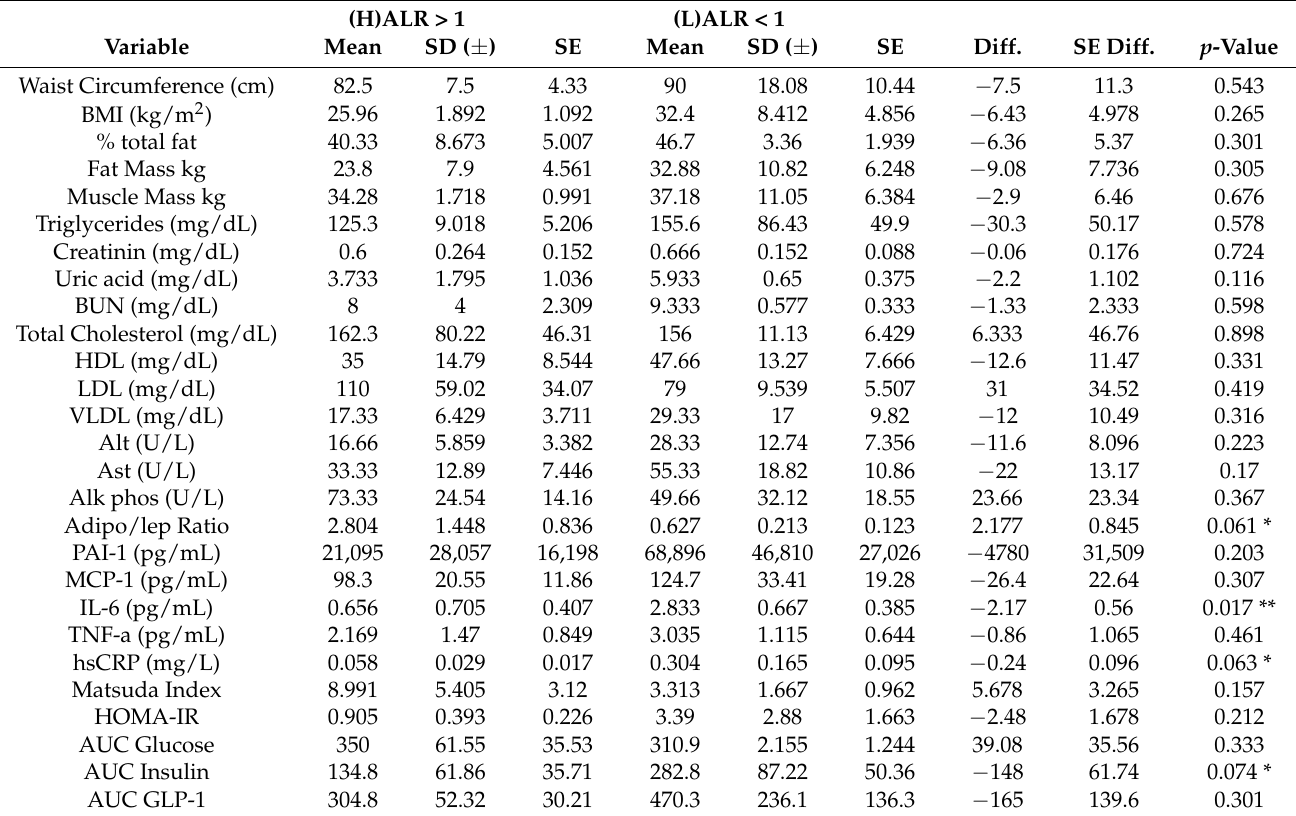
Figure 4. Heat maps with differences in miRNA signatures for Time 180 ′ (peak of postprandial response) after a mixed meal among participants with (H) vs. (L)ALR.